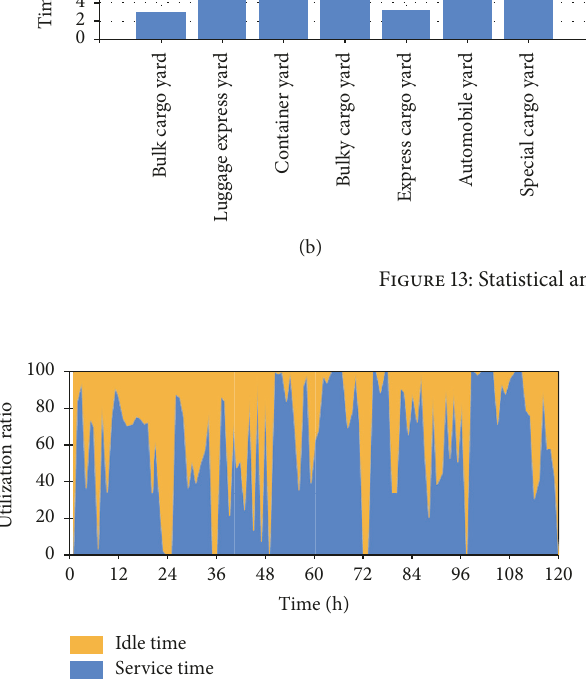
records detailed information on several key performance